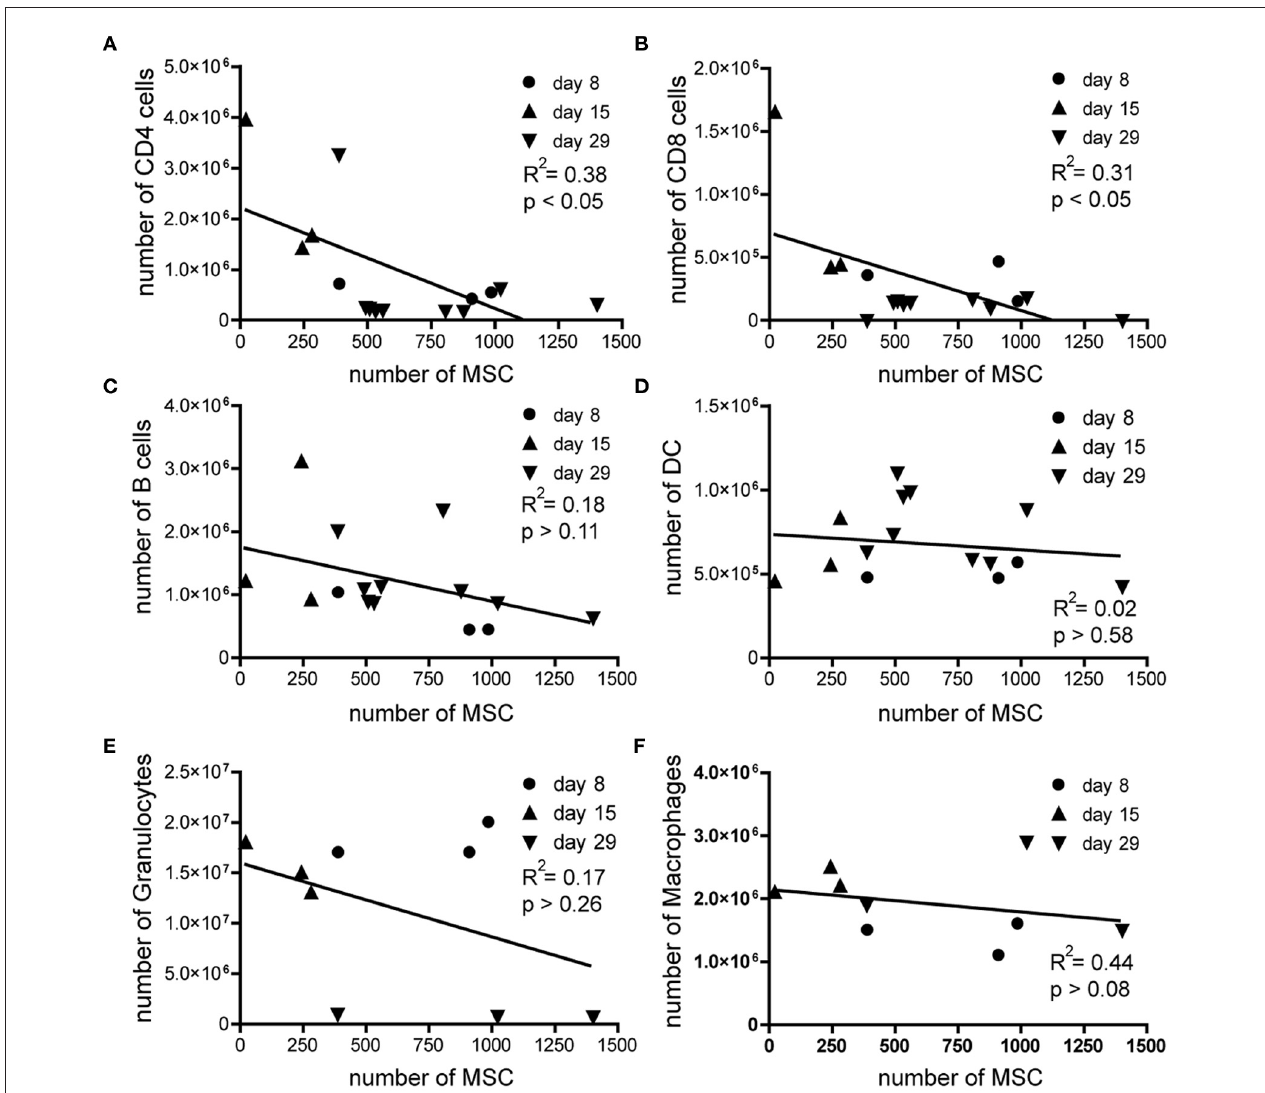
FIGURE 2 | The number of MSCs negatively correlates with both CD4 and CD8 T cells during EAE. Absolute numbers of MSCs plotted against the absolute numbers of (A) CD4 T cells, (B) CD8 T cells,